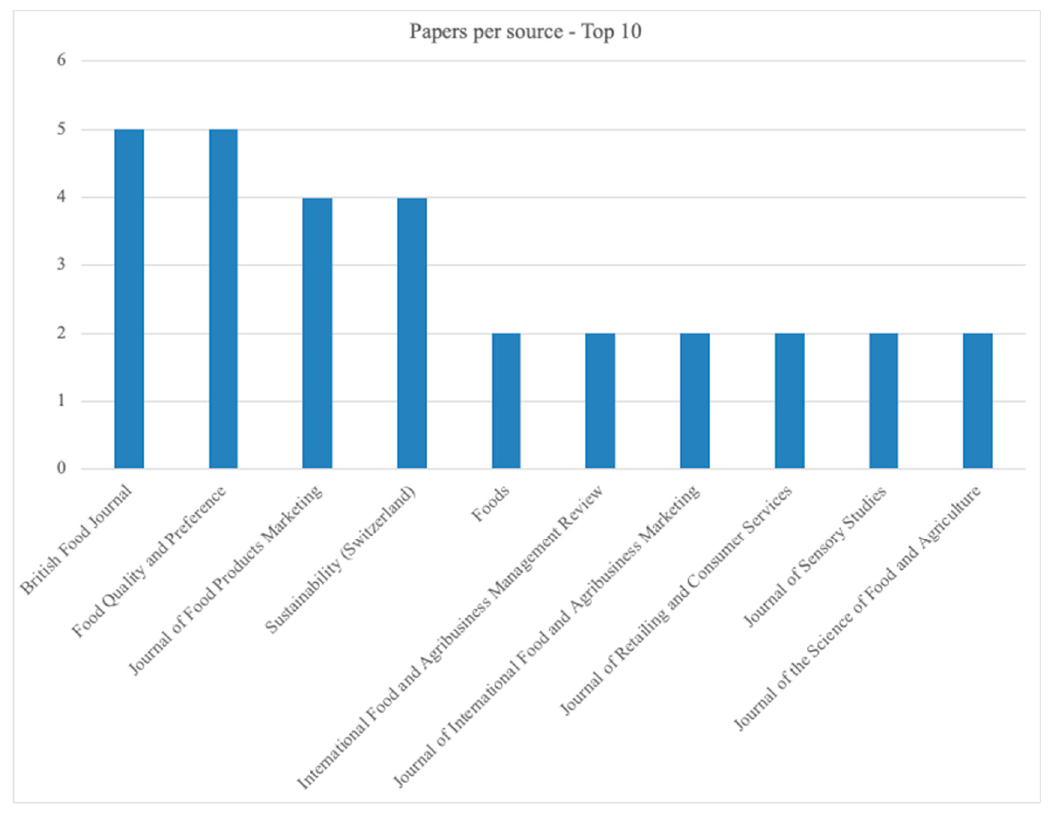
Figure 3. Source Top 10.